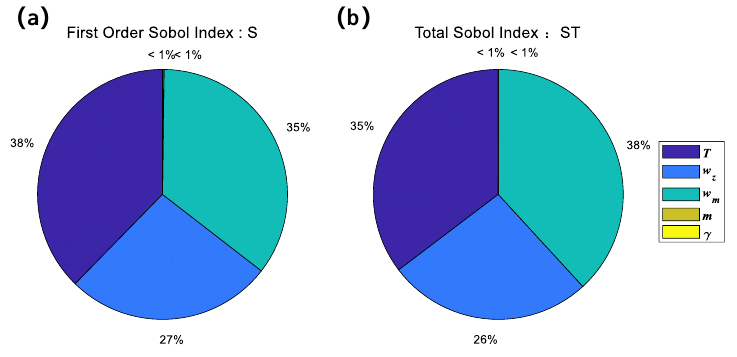
Figure 7. ( a ) First-order Sobol index pie charts and ( b ) total Sobol index pie charts of the five parameters for the infrasound propagation distance R . The five uncertain atmospheric environmental parameters are independently and uniformly distributed. The number of Sobol samples N is 2000. Table 2. First Sobol index S and Total Sobol index ST of each atmospheric parameter for the infra- sound propagation distance R . T w z w m m γ S 0.3768 0.2684 0.3528 0.0016 0.0004 ST 0.3533 0.2649 0.3814 0.0003